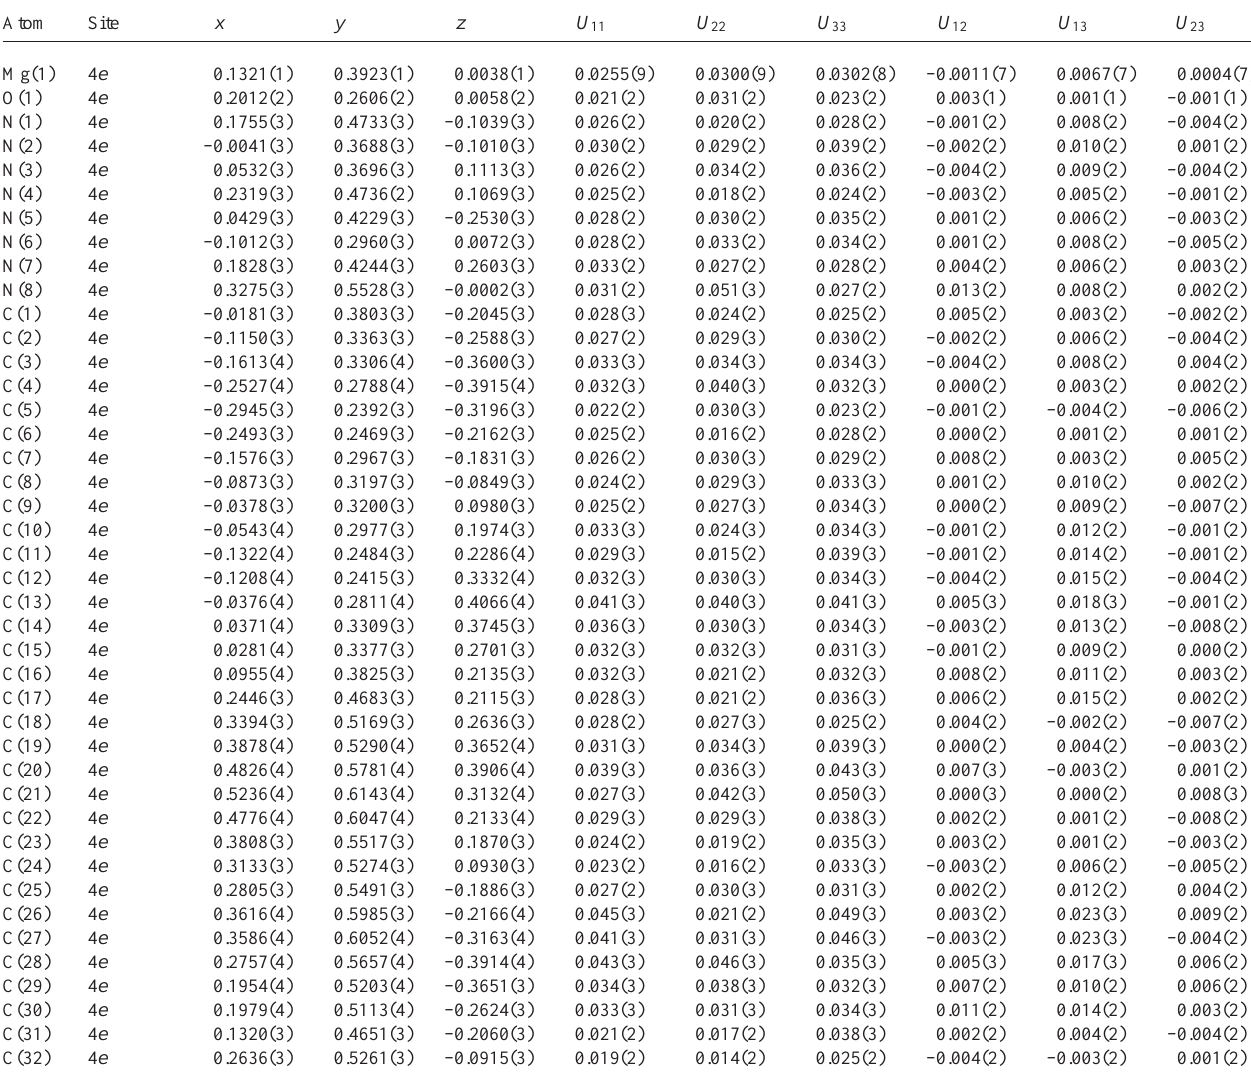
Table 3. Atomic coordinates and displacement parameters (in Å 2 )